Question: Briefly state, in one sentence, what is plotted here.
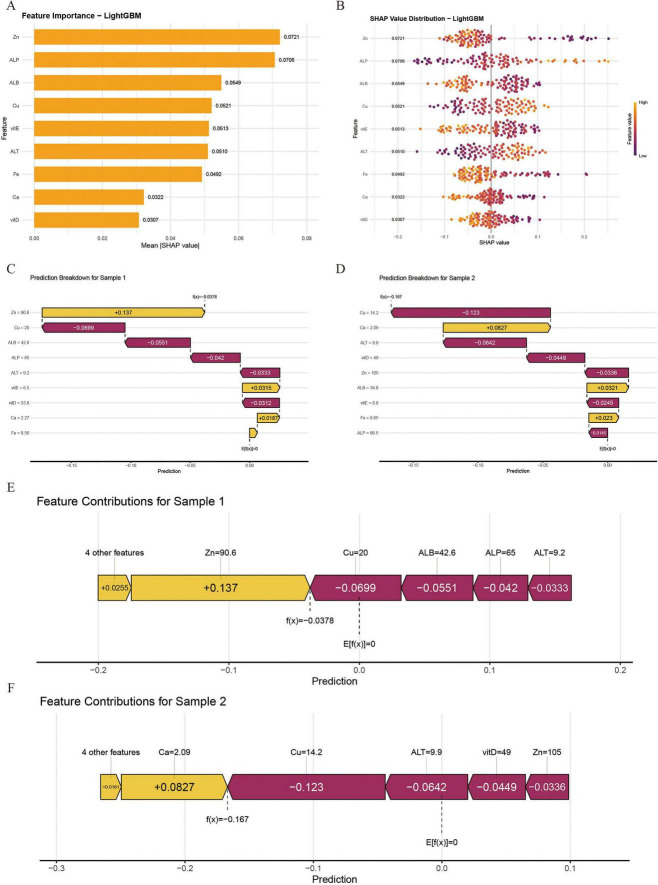
Answer: SHAP-based interpretation of the LightGBM model. (A) Variable importance ranking based on mean absolute SHAP values; (B) SHAP summary plot showing the distribution of feature values and their direction of contribution to model output; (C) SHAP waterfall plot for sample 1; (D) SHAP waterfall plot for sample 2; (E) SHAP force plot for sample 1, corresponding to the same individual shown in (C) ; (F) SHAP force plot for sample 2, corresponding to the same individual shown in (D) .